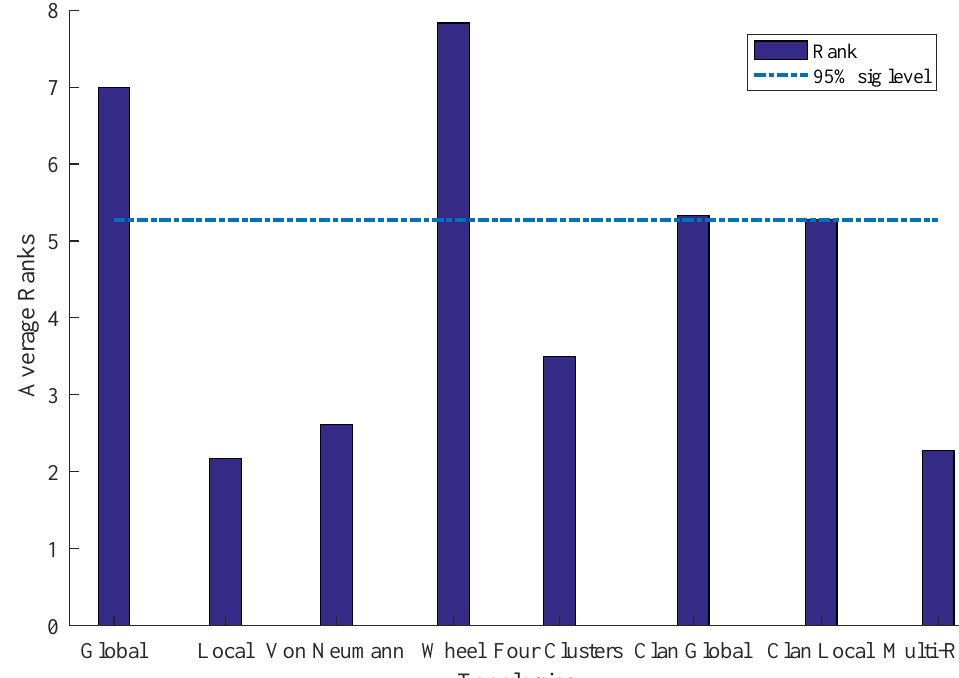
Figure 12. A comparison of topologies with the Bonferroni–Dunn’s